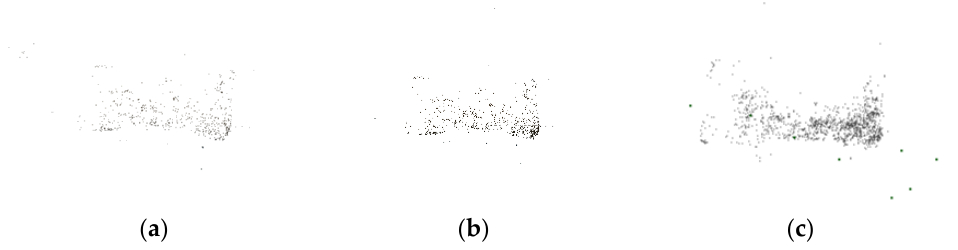
Figure 11. ( a – c ) are sparse models reconstructed using global, incremental and hybrid SFM proposed in this paper.